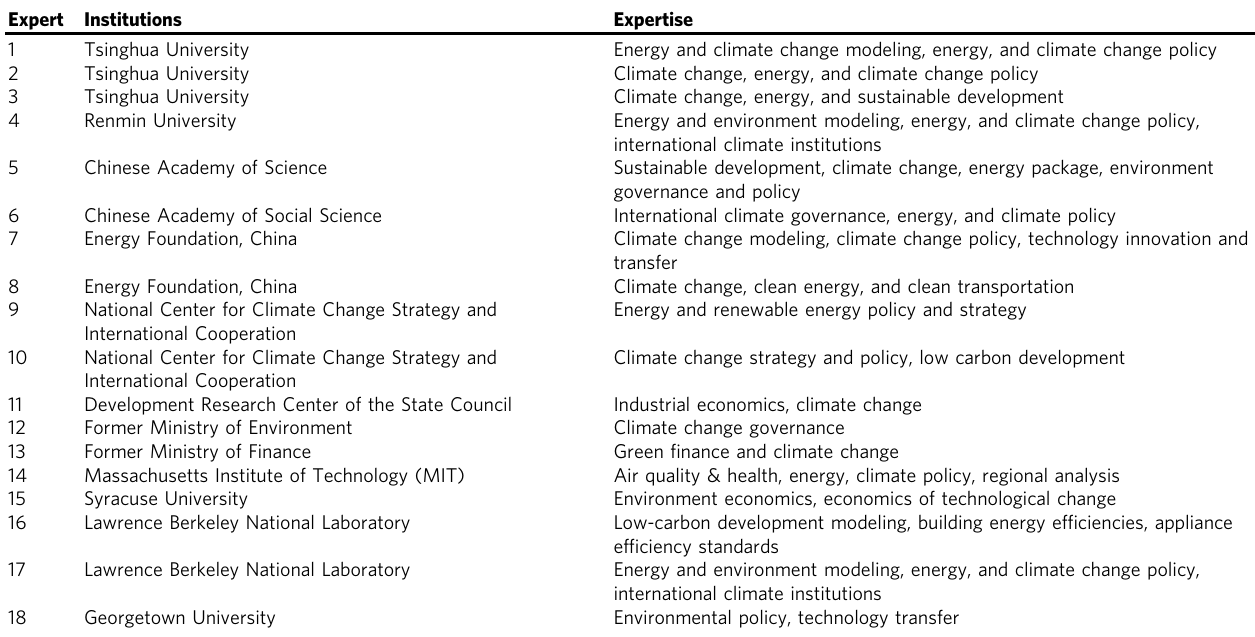
Table 1 Background information on experts surveyed